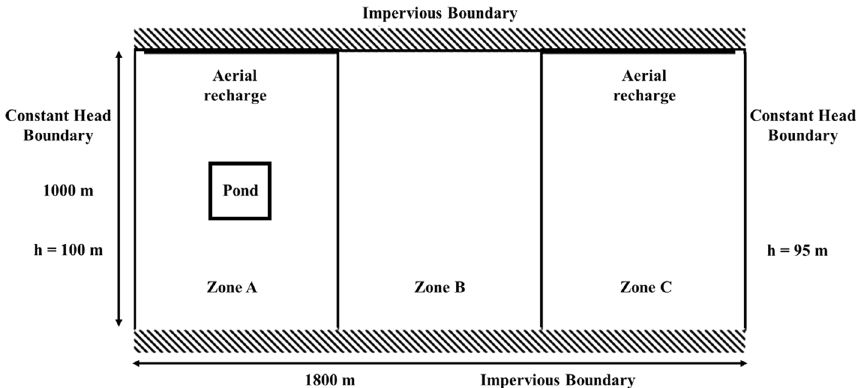
Fig. 1 Hypothetical aquifer